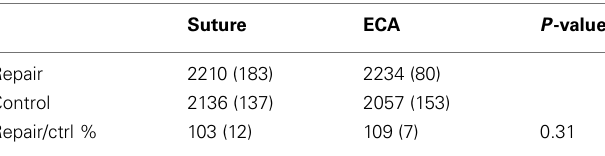
Table 2 | Mean (SD) morphometric data on cross-sectional soma size area ( μ m 2 ) and correlation (%) between repair and control, respectively, of RLMs representing the LGC in the lateral ventral horn of the L5 spinal cord 6months after transection and repair of the left rat sciatic nerve with either ECA or epineurial sutures ( n = 8 in each